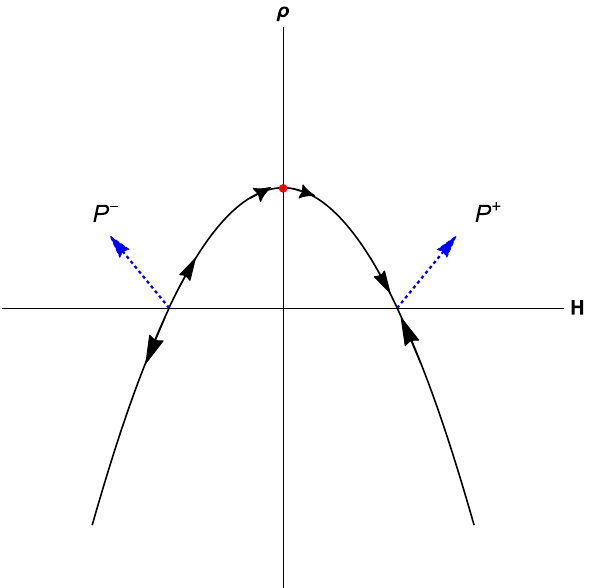
Fig. 3 Atypicalphasetrajectoryinthephasespaceplane ( H ,ρ) corre- sponding to model A . This plot shows that the evolution of the Universe has started from an unstable state and terminates in a stable phase. The bounce event is an unstable (of saddle type) fixed red